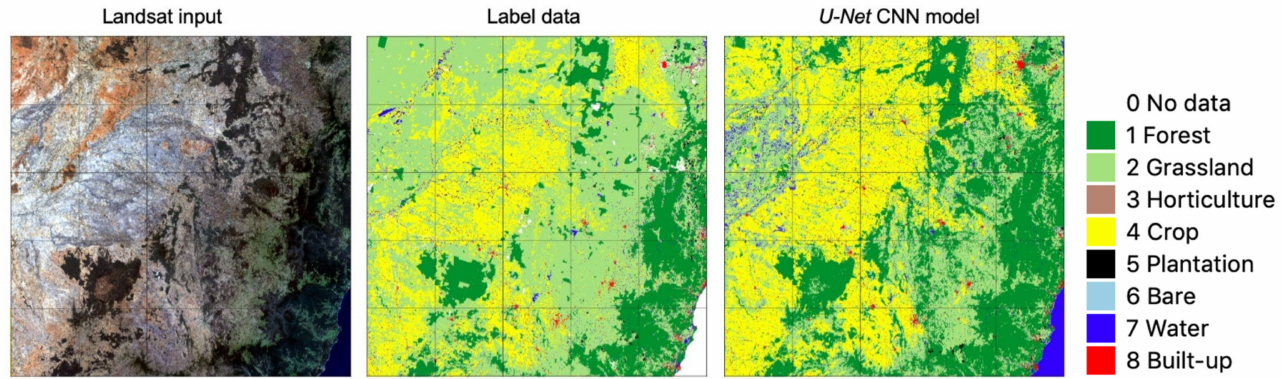
Figure 11. Landsat input (true colour RGB), label data and U-Net CNN model prediction for area (~500 km × 500 km) northeast of study